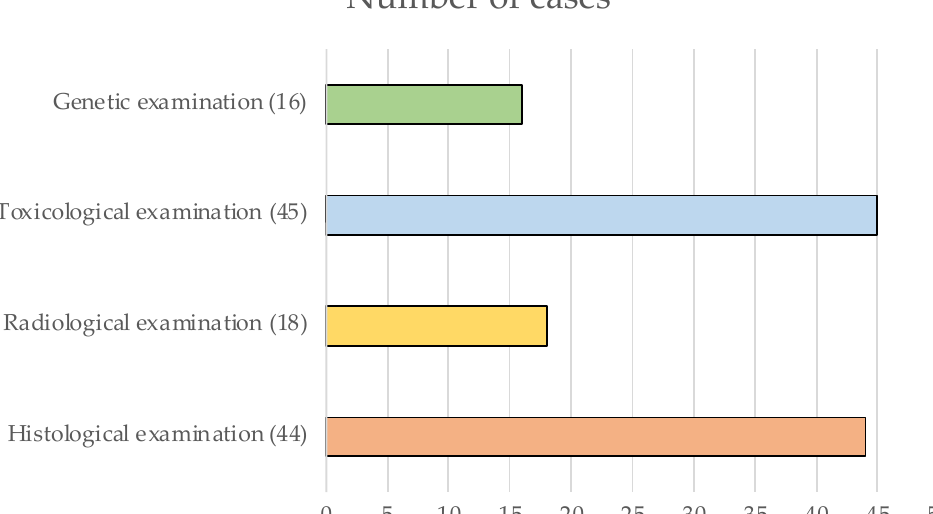
Figure 3. The graph shows the number of subjects who were found charred or with different de ‐